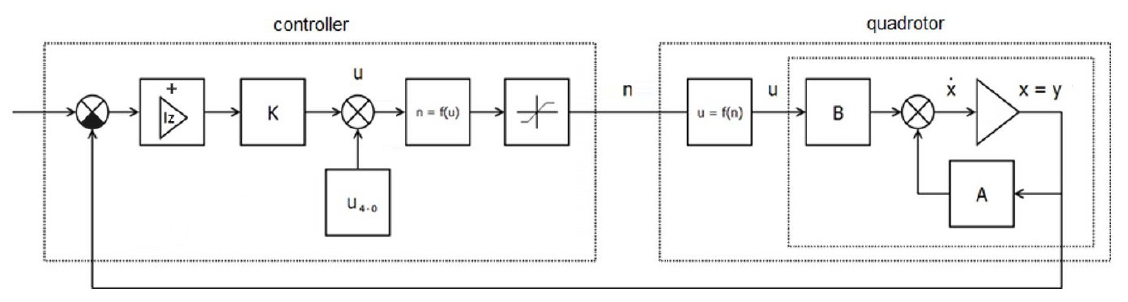
Figure 2. Designed controller.